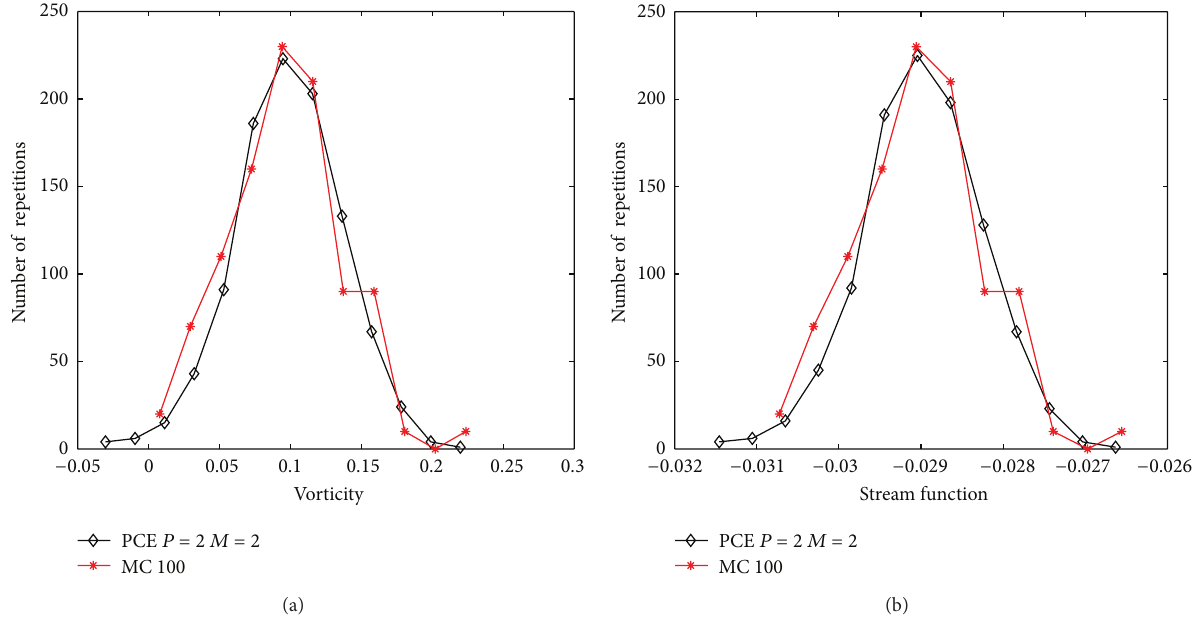
Figure 6: p.d.f of vorticity (a) and stream function (b) at 𝑥 = 0.1698 and 𝑦 = 0.7767 using the current solver and the MC simulations, mean viscosity = 0.01 and 500 elements cavity mesh.